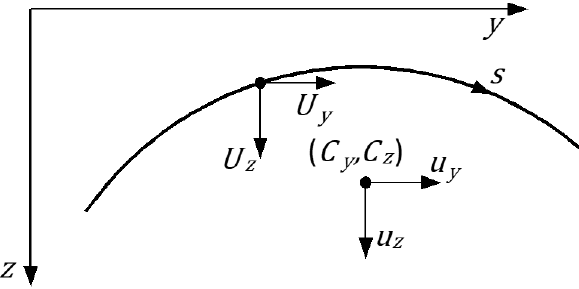
Figure 3: Description of displacements for cross